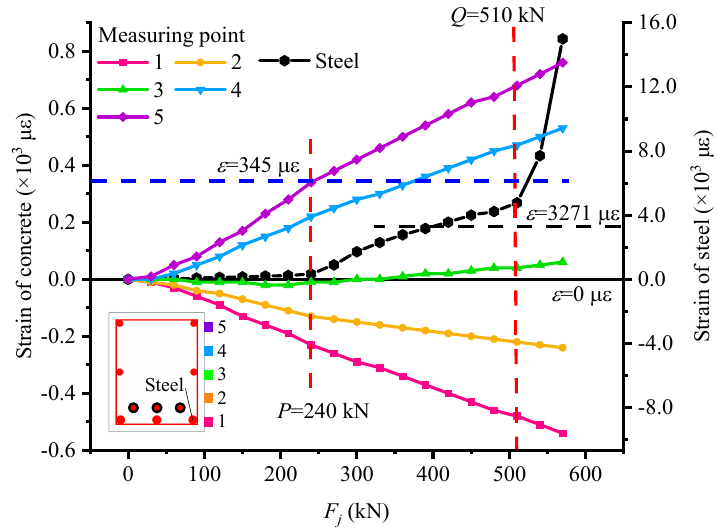
Figure 4. Strain diagram of unbonded No. 4 beam (UP4).